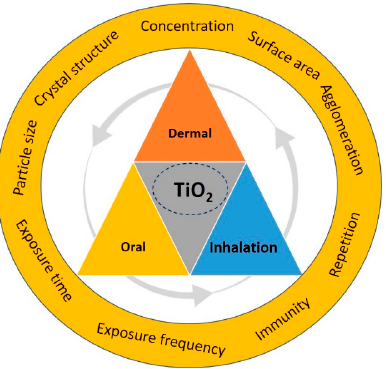
Figure 11. Risk management strategies for human exposure to TiO 2 NPs via different exposure routes.